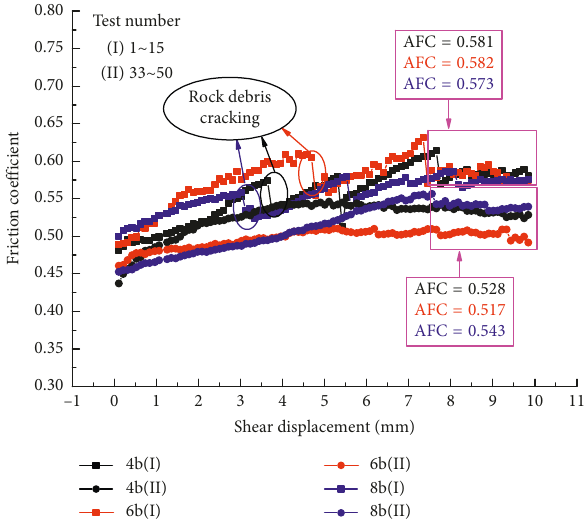
Figure 8: Direct shear testing results for dry friction tests.